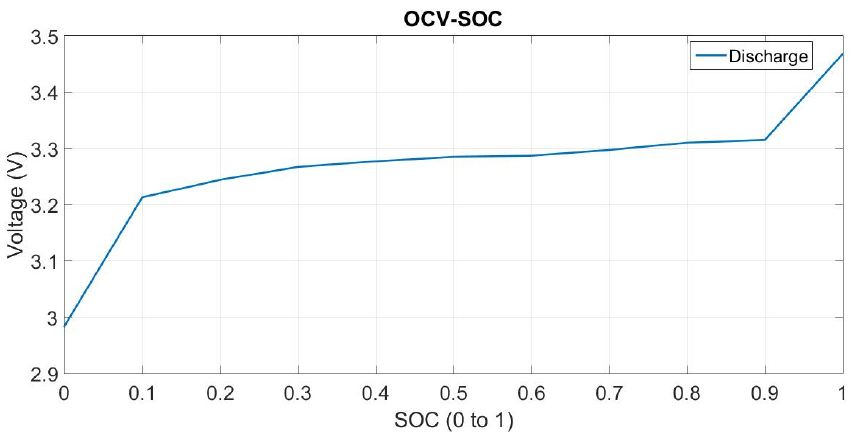
Figure 2. OCV-SOC breakpoints used in the model. The results in each breakpoint for b 0 and b 1 , are presented in Table 1. Table 1. Parameter 𝑏 (cid:2868) and 𝑏 (cid:2869) in each SOC breakpoint.